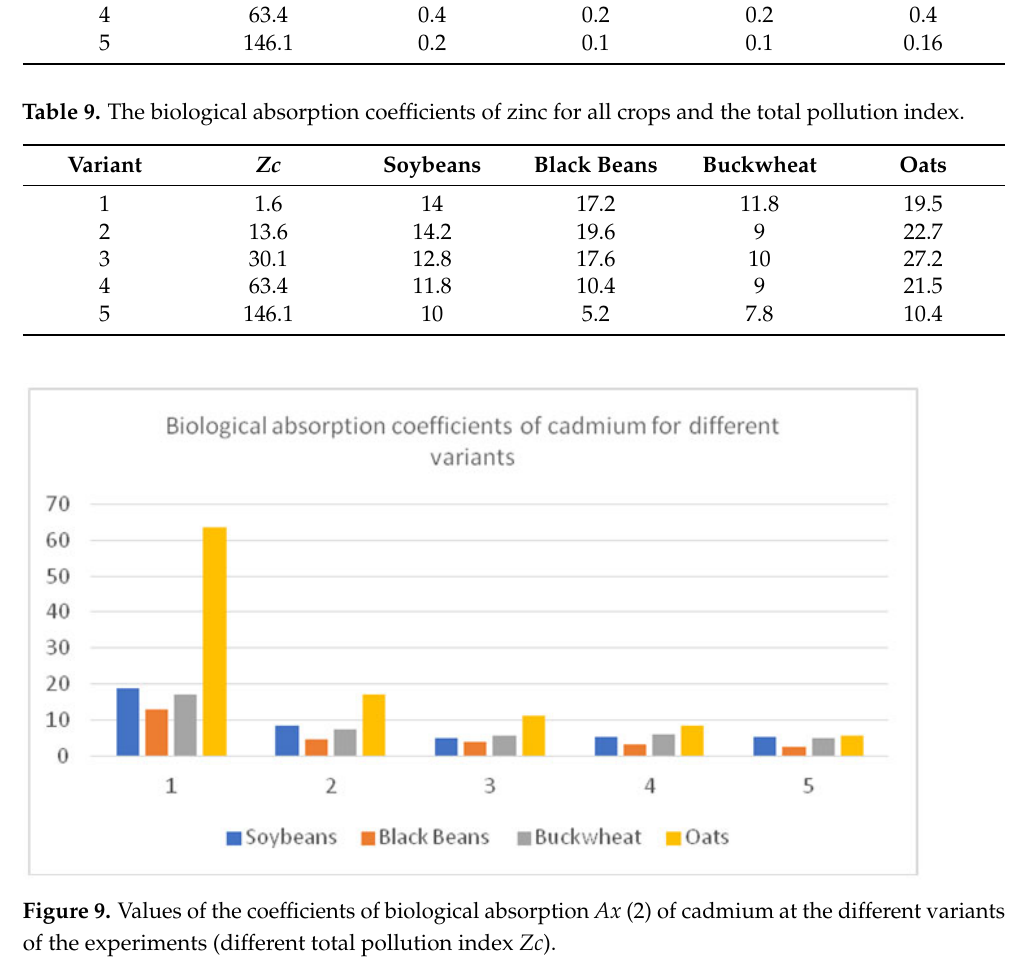
Figure 11. Values of coefficients of biological absorption A х (2) of lead at the different variants of the experiments (different total pollution index Zc ). Figure 12. Values of coefficients of biological absorption A х (2) of zinc at the different variants of the experiments (different total pollution index Zc ).